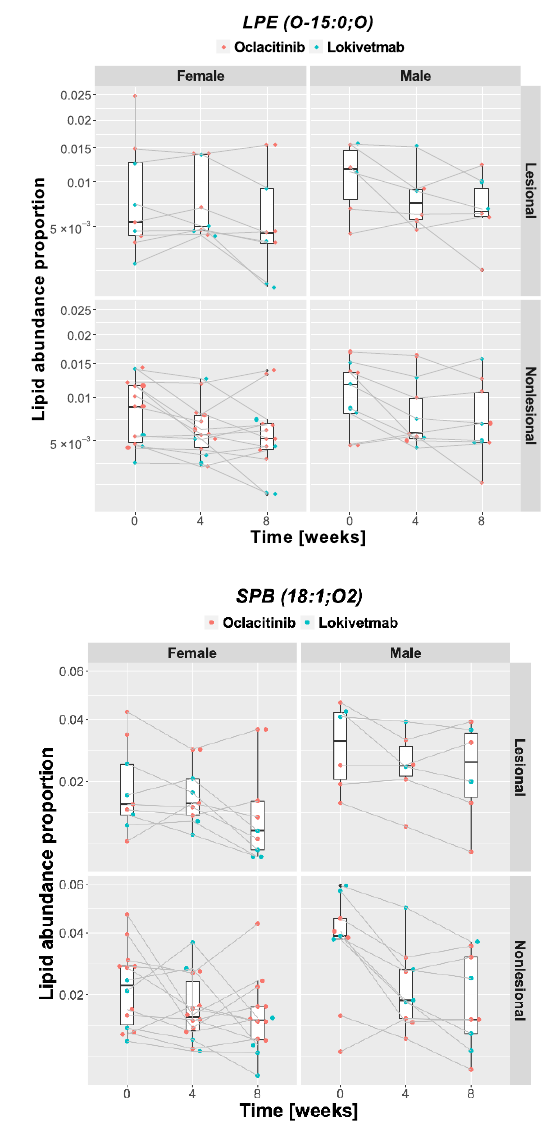
Figure 11. Examples of skin lipid with abundance changing significantly during the treatment.